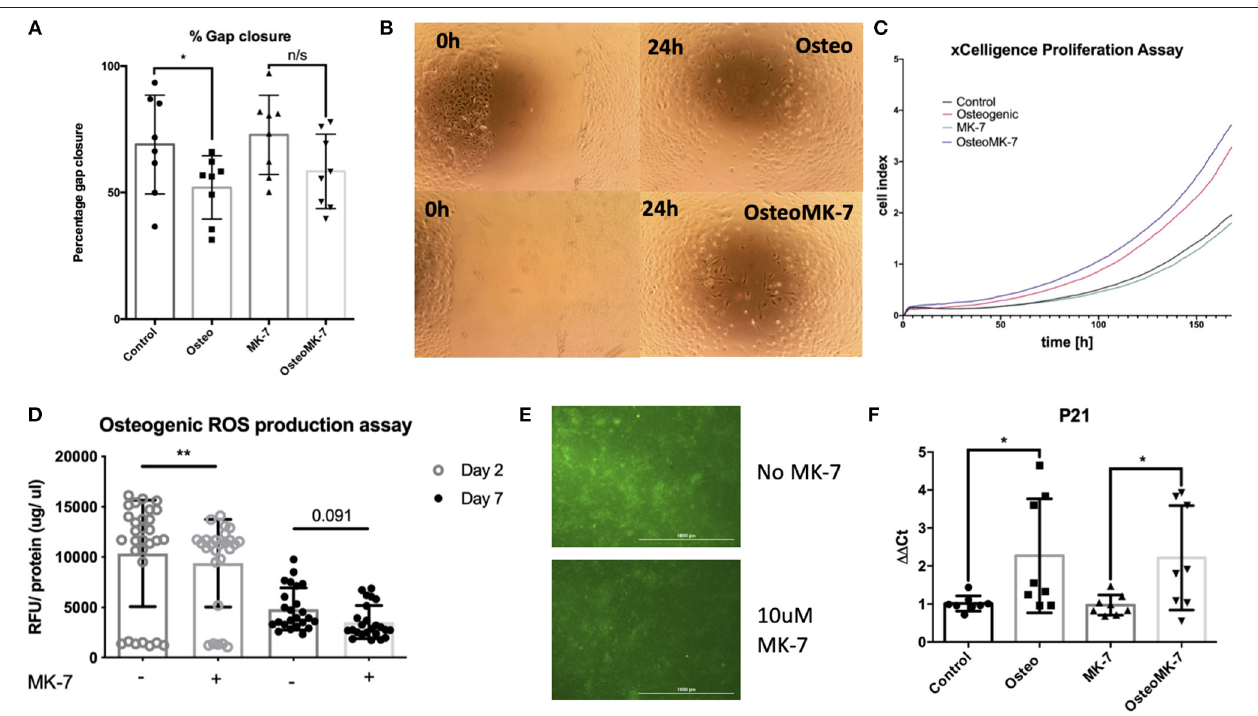
FIGURE 5 | Activity of MK-7 on Migration, ROS and cell cycle regulator P21. Scratch wound assay reveals that MK-7 has the greatest gap closure followed by control, then OsteoMK7 and Osteo last (A) . While the difference between osteogenic medium and control alone is statistically significant ( p = 0.0499), there is less of a difference in gap closure between OsteoMK-7 and MK-7 (B) . xCELLigence proliferation assay reveals that OsteoMK-7 has the greatest increases in proliferation over 1 week compared to the other conditions (C) . OsteoMK-7 had significantly higher proliferation ( p < 0.0196) compared to Osteo alone. Further MK-7 supplementation significantly reduces the production of ROS species under osteogenic conditions compared to the osteogenic control (D,E) ( p = 0.0047). Wherein by day 7 of treatment the differences are no statistically significant but remain (D) also shown by visual representation of the DCFDA staining between the two different conditions (E) . Further at day 2 we note by RT-qPCR analysis, a significant upregulation of cell cycle regulator P21 under both osteogenic conditions compared to controls (F) ( p = 0.0379, p = 0.0499). * p < 0.05, ** p <